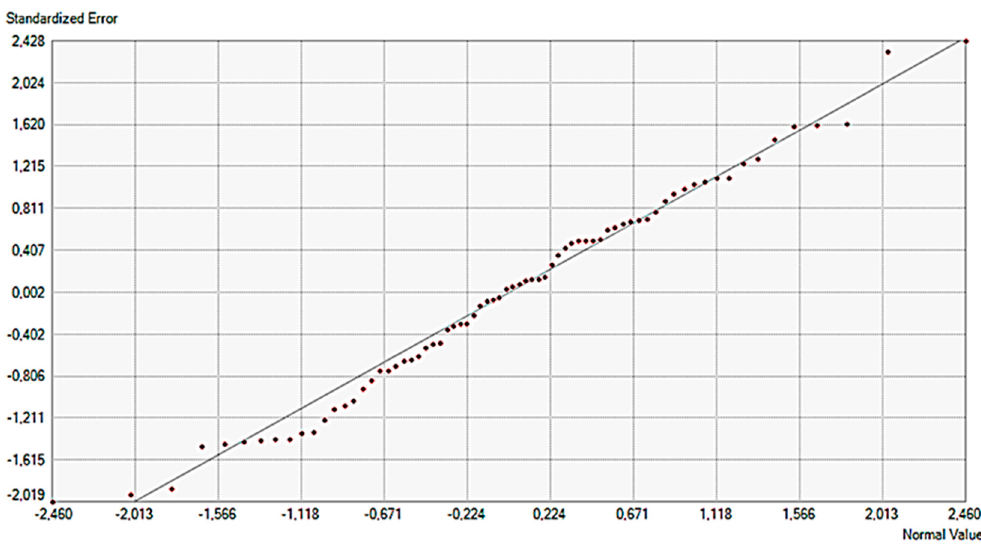
Figure 9. The normal QQ (Quantile – Quantile) plot graph of the standardized error. Table 2. Prediction errors of the ordinary Kriging method.